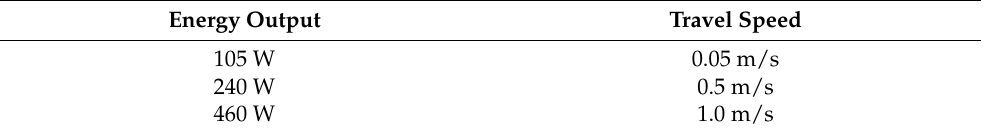
Figure 6. Processed AlMg3 base plate. Table 1. Laser energy outputs and travel speeds.